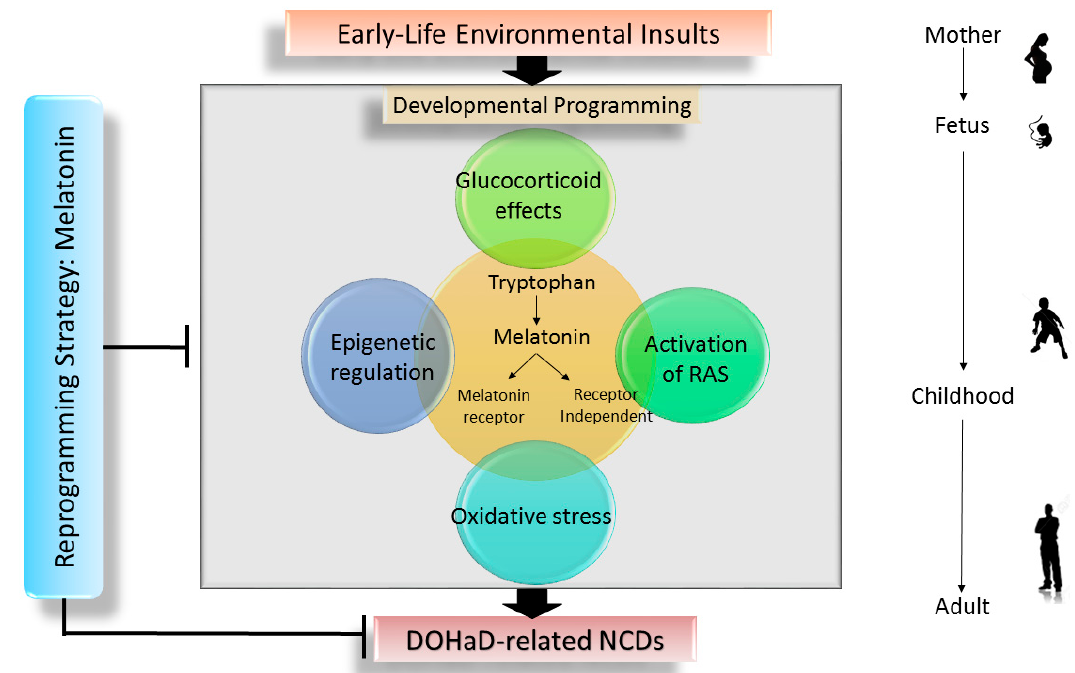
Figure 1. Schema outlining the early-life insults that drive the potential mechanisms that may underpin the developmental programming, leading to developmental origins of health and disease (DOHaD)-related non-communicable diseases (NCDs) in adulthood. There is a link between melatonin synthesis and signaling pathway close to oxidative stress, epigenetic regulation, glucocorticoid effect, and renin-angiotensin system (RAS). Early intervention with melatonin could be a reprogramming strategy to prevent the development of DOHaD-related NCDs in later life.